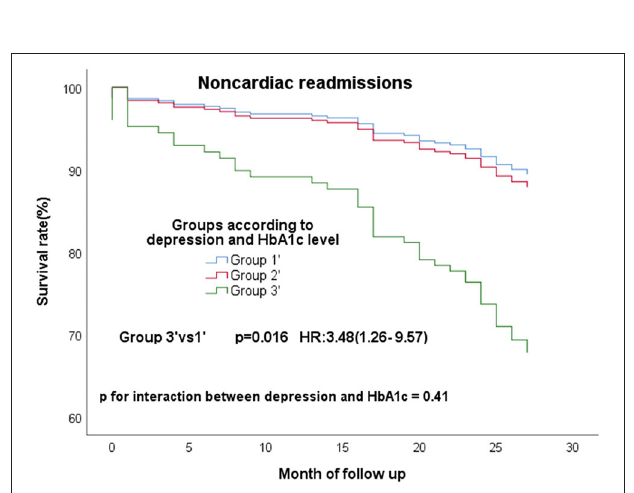
FIGURE 5 | Cox regression curves for noncardiac readmission by the four groups of CAD patients with diabetes. (Group1”: patients without clinical depression and low HbA1c; Group2”: patients with clinical depression and low HbA1c, patients without clinical depression and high HbA1c; Group3”: patients with clinical depression and high